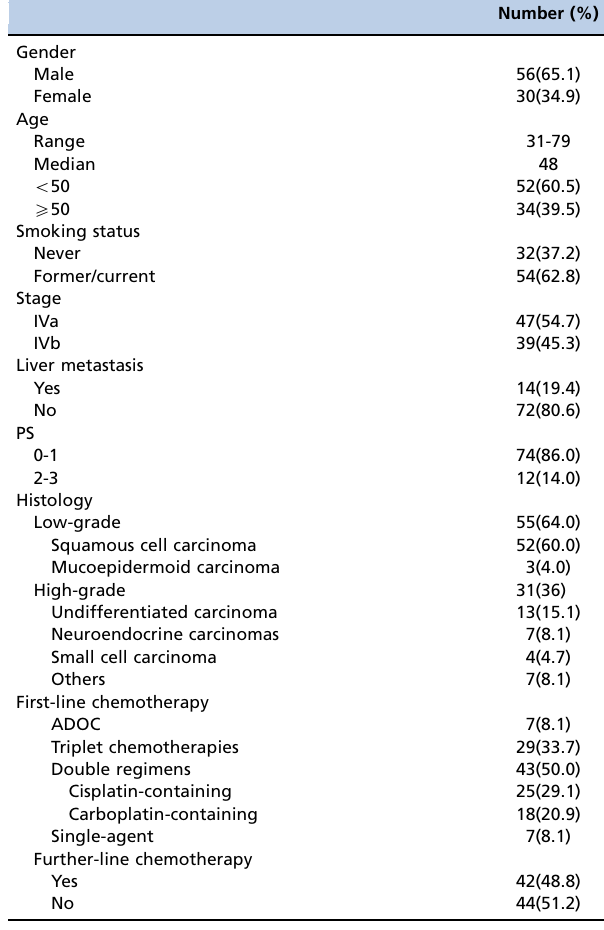
Table 1 - Demographic characteristics of the study